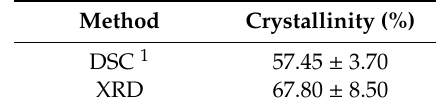
Table 3. Degree of crystallinity (X C ) of UHMWPE